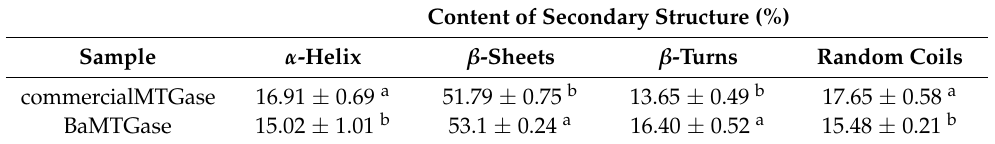
Figure 5. The FT − IR spectra of SPI gel. Table 2. Secondary structure constituents of samples.